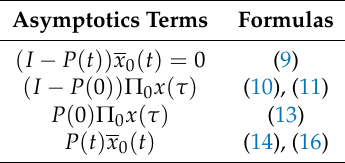
Table 1. The algorithm for finding the zero-order asymptotics